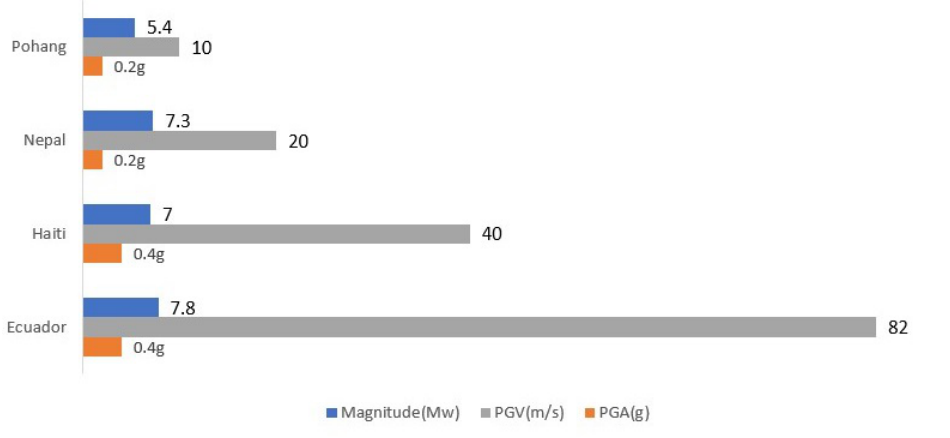
Figure 2. Properties of selected earthquakes.